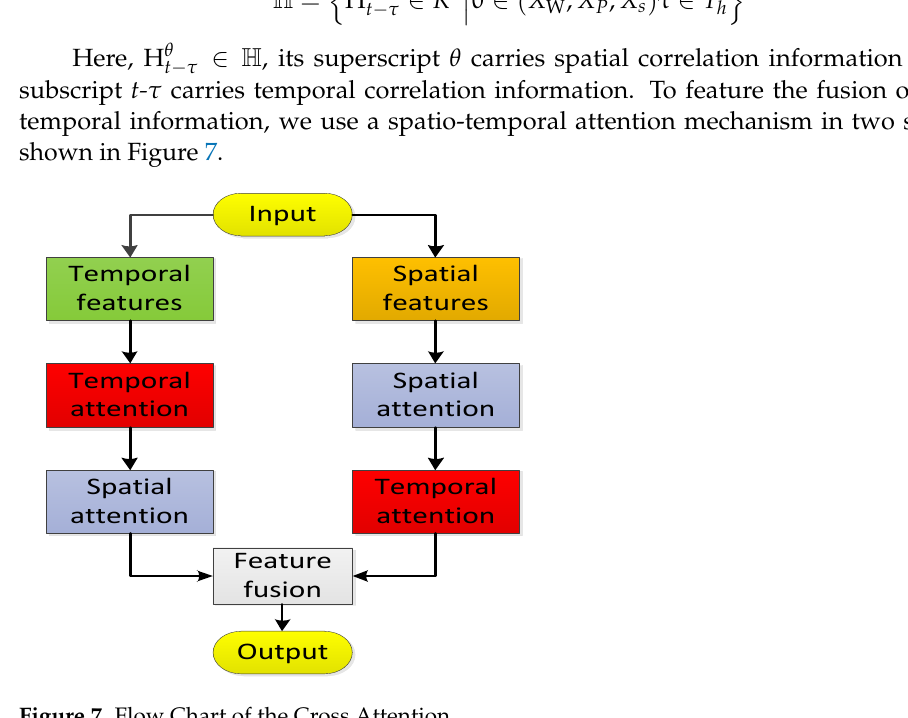
Figure 7. Flow Chart of the Cross Attention.